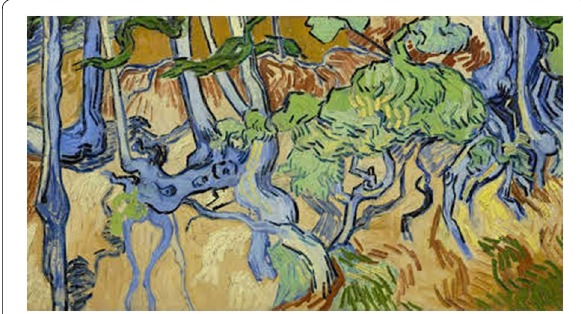
Fig. 4 Tree roots (July 1890), Van Gogh Museum, Amsterdam, The